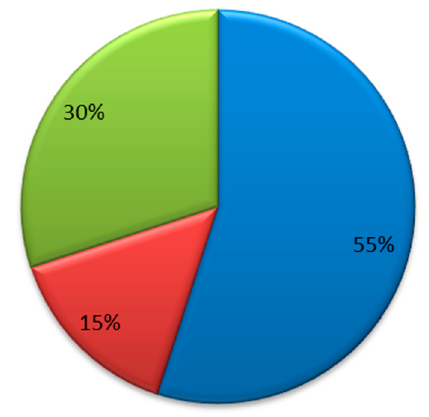
Figure 9. Origin of the publications by venue.